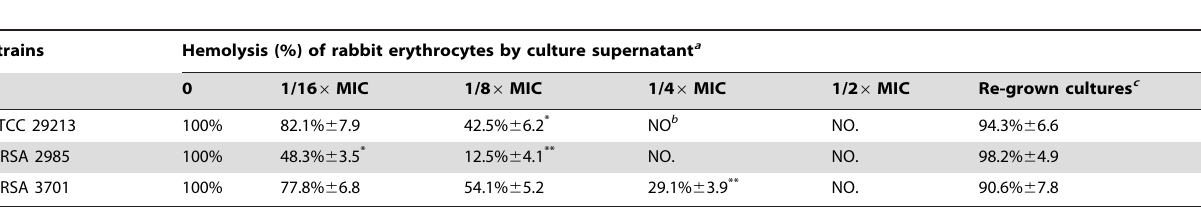
Table 1. Hemolytic activities of S. aureus culture supernatants treated with graded subinhibitory concentrations of perilla oil.